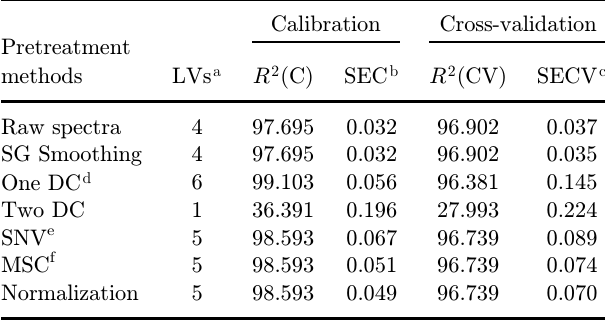
Table 4. Comparison of di®erent calibration models of seco- loganic acid concentration developed with di®erent pretreat- ment